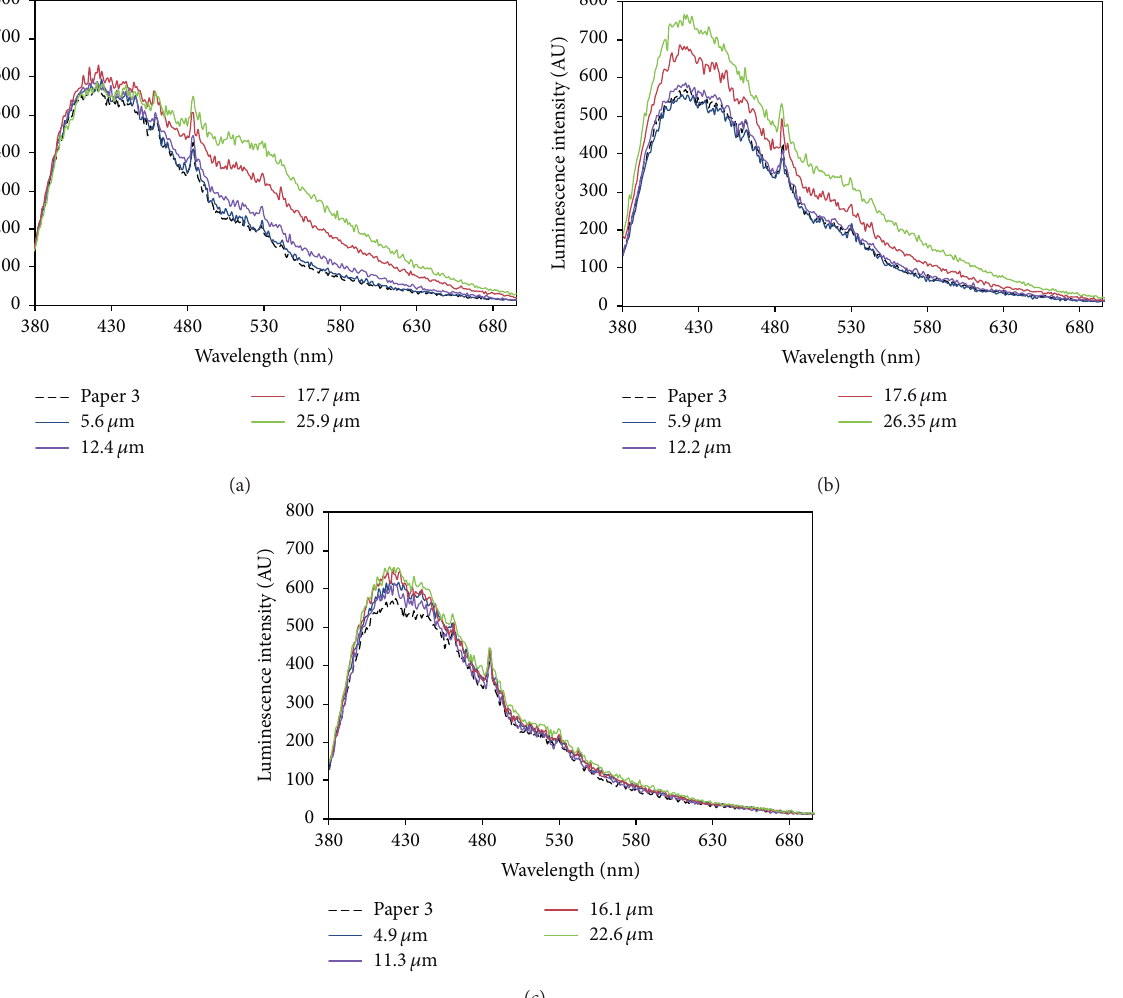
Figure 10: The luminescence spectra of images printed onto the paper with the maximum content of OBAs (paper 3) and ink compositions with the following contents of the fluorescent component (ZnO nanoparticles): (a) 0.15%; (b) 0.1%; (c)